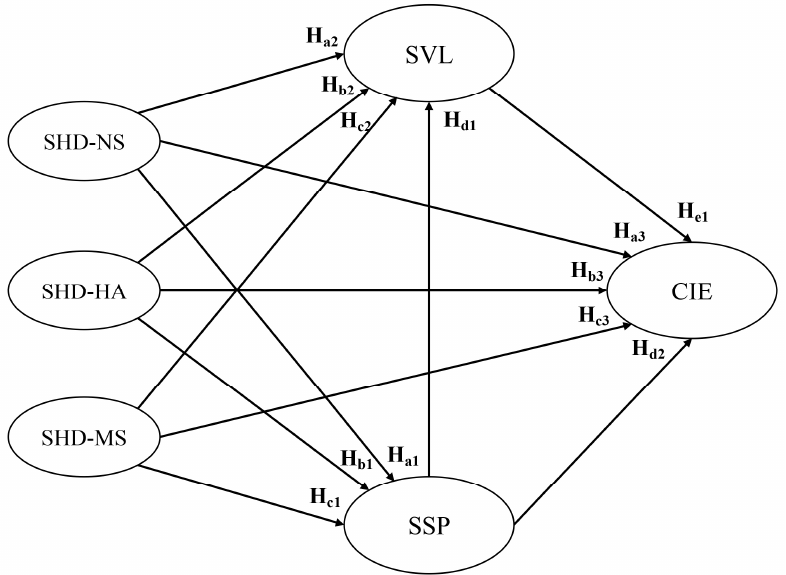
Figure 4. A conceptual model of the SHD influencing visiting experience in Kulangsu, SHD-NS: harmonious degree of natural sound, SHD-MS: harmonious degree of mechanical sound, SHD-HS: harmonious degree of human sound, SPE: soundscape perception, SVL: satisfaction degree of visual landscape, CIE: comprehensive impression evaluation.